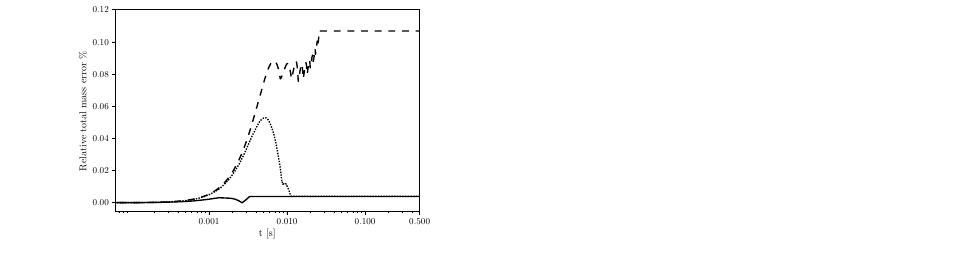
Figure 9. Oscillating water case. Evolution of the relative error ε tot for different CFL max . Grid size 512 1 cells. Legend: ( ) CFL max = 0.001; ( ) CFL max = 0.01; ( ) CFL max = ×